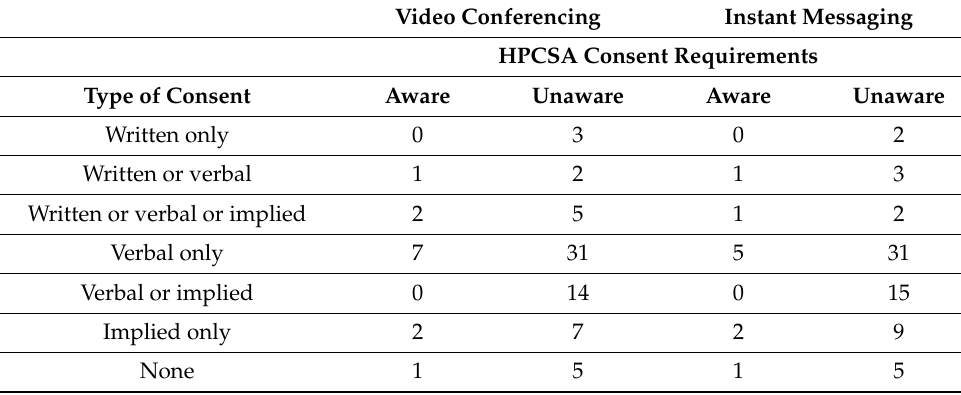
Table 4. Form of consent obtained by doctors ( n = 79) for electronic communication based on their awareness of the HPCSA requirements. Video Conferencing Instant Messaging Type of